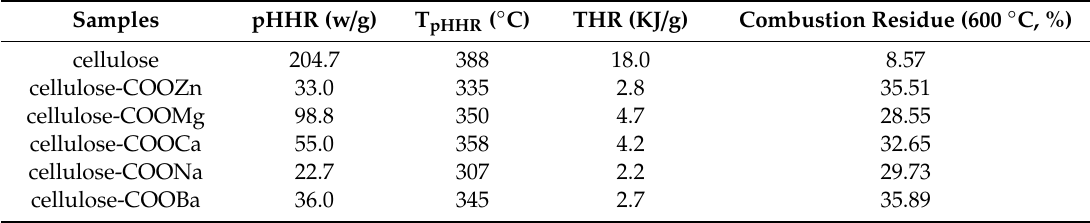
Figure 7. The heart release rate (HRR) curves of cellulose ( a ), cellulose-COOZn ( b ), cellulose-COOMg ( c ), cellulose-COOCa ( d ), cellulose-COONa ( e ), and cellulose-COOBa ( f ) at 1 K/s heating rate. Table 2. Microscale combustion calorimetry (MCC) data of cellulose and TOC.